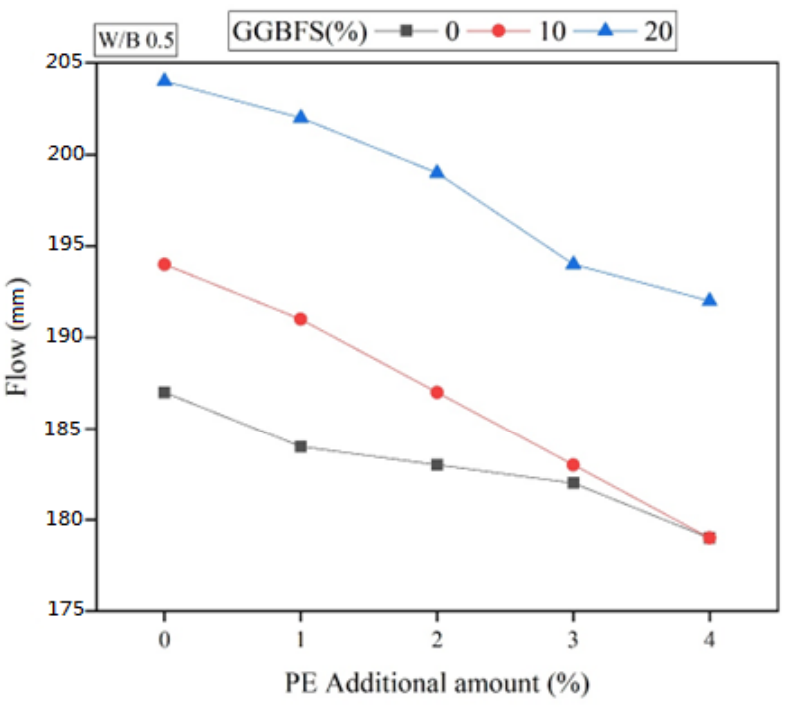
Figure 4. The flow of cement mortars with the addition of different ratios of waste PE and GGBFS replacement.